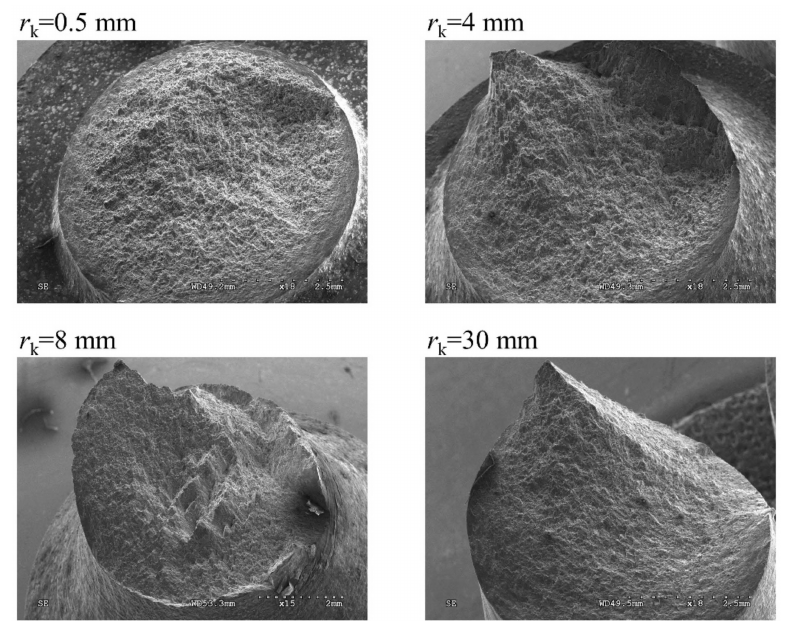
Figure 14. Fracture surface for the load configurations of P 3 n for di ff erent notched